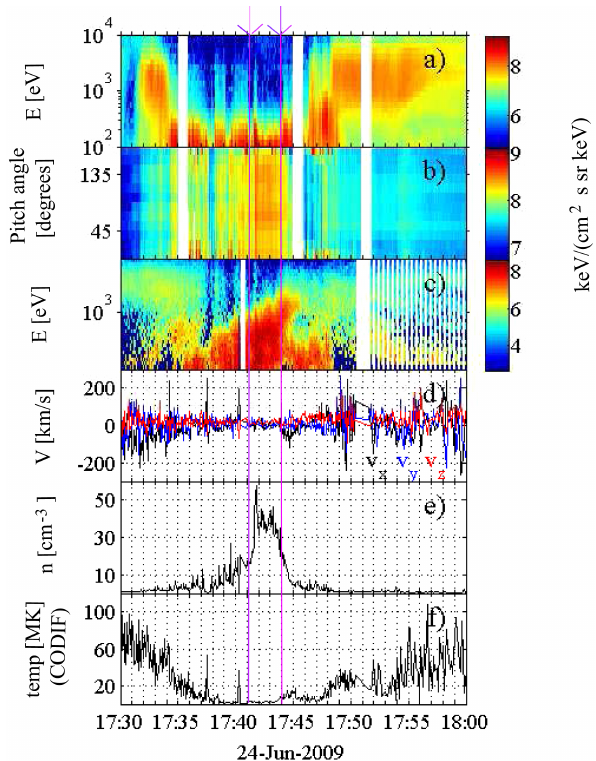
Figure 1. Cluster 4 on 24 June 2009: ( a) electron spectrogram, (b) pitch angle distribution of electrons, (c) ion spectrogram, (d) ion velocity in GSE, (e) ion density, (f) parallel (to mag. field) temper- ature. Two violet lines mark the cusp